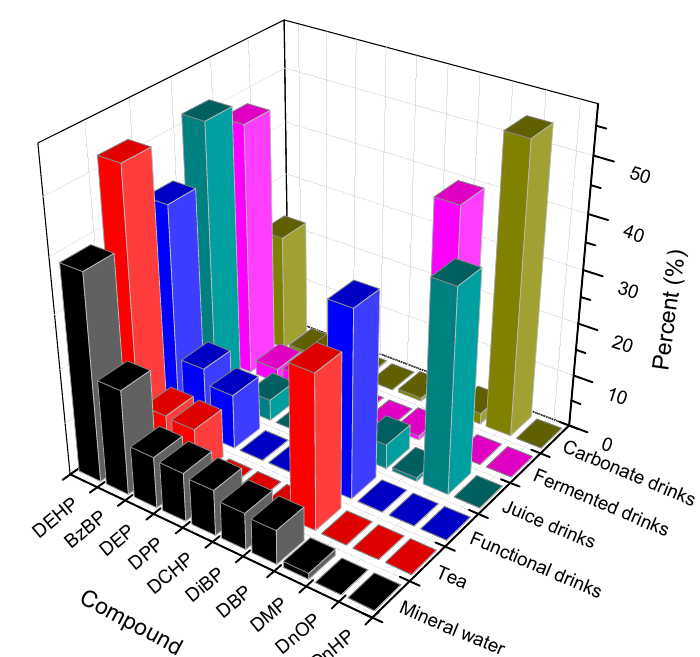
Figure 4. The distribution of 10 phthalate compounds in different kinds of samples. Note: Dimethyl phthalate, DMP; Diethyl phthalate, DEP; Dipropyl phthalate, DPP; Diisobutyl phthalate, DiDP; Benzyl butyl phthalate, BzBP; di- n -hexyl phthalate, DnHP; di (2-ethylhexyl) phthalate, DEHP; di- n -octyl phthalate, DnOP; Dicyclohexyl phthalate, DCHP and di- n -butyl phthalate, DPBP.